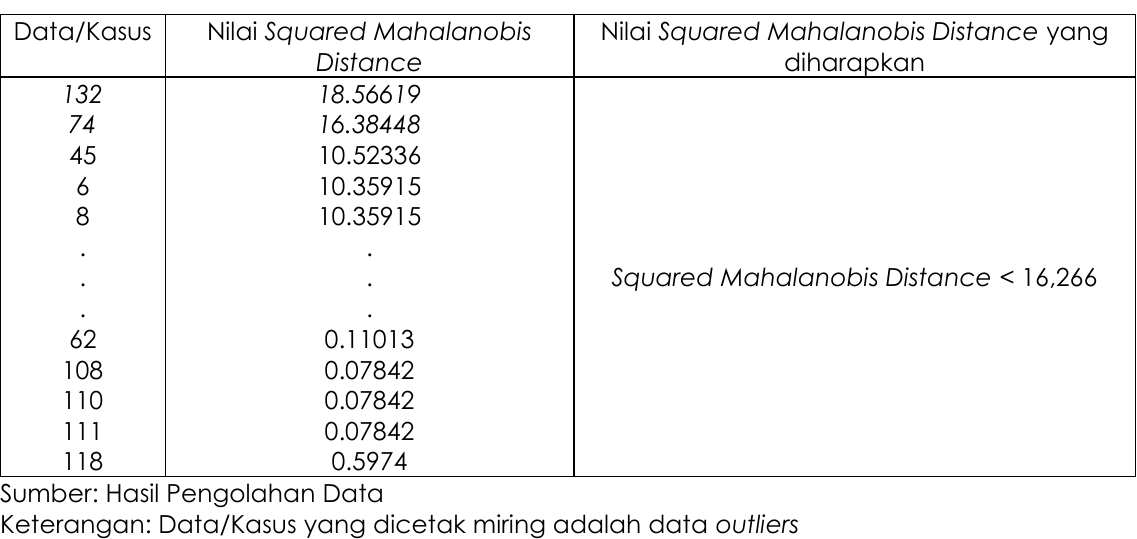
Tabel 2. Hasil Uji Outliers – Squared Mahalanobis